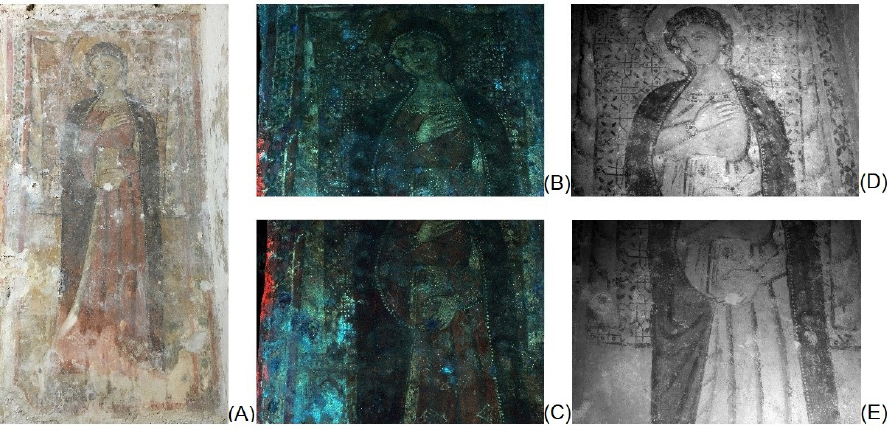
Figure 3. Virgin mural painting: Photographs by visible light ( A ), UV fluorescence images ( B , C ), Infrared images (950 nm) ( D , E ).